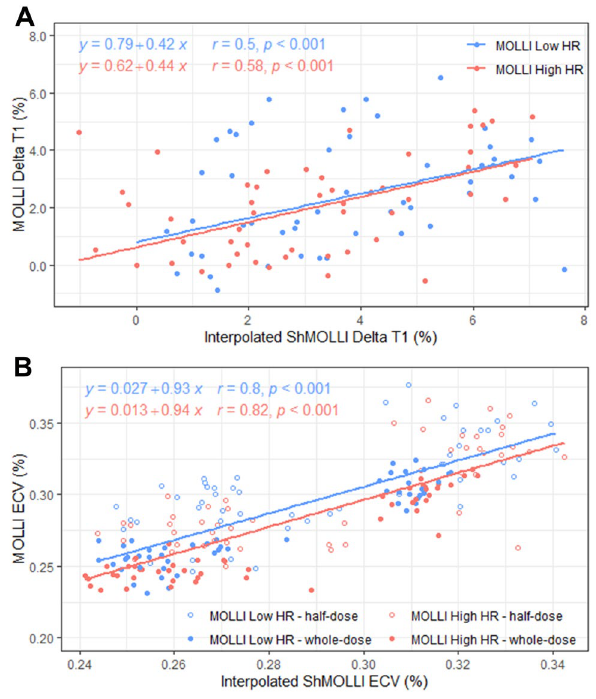
Figure 7. Impacts of MOLLI choice on estimation of stress delta T1 and ECV. Only modest correlations between methods are seen for MOLLI Low HR (r = 0.5) and MOLLI High HR (r = 0.58) respectively for delta T1 ( A ). Relationships are stronger for ECV for MOLLI Low HR (r = 0.8) and MOLLI High HR (r = 0.81) with distributions also shown for half-dose and whole-dose gadolinium ( B ). MOLLI variant samples correspond to time equivalent interpolated ShMOLLI.